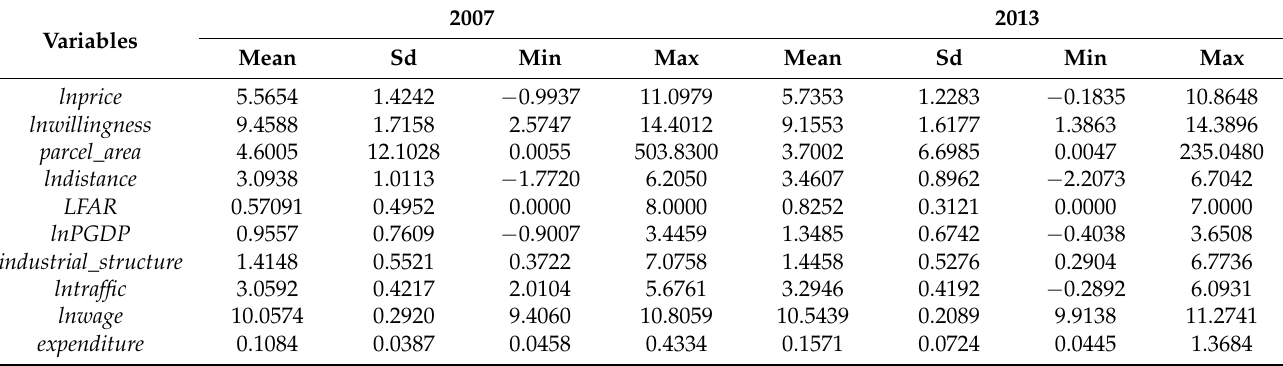
Table 3. Descriptive statistics of continuous variables.